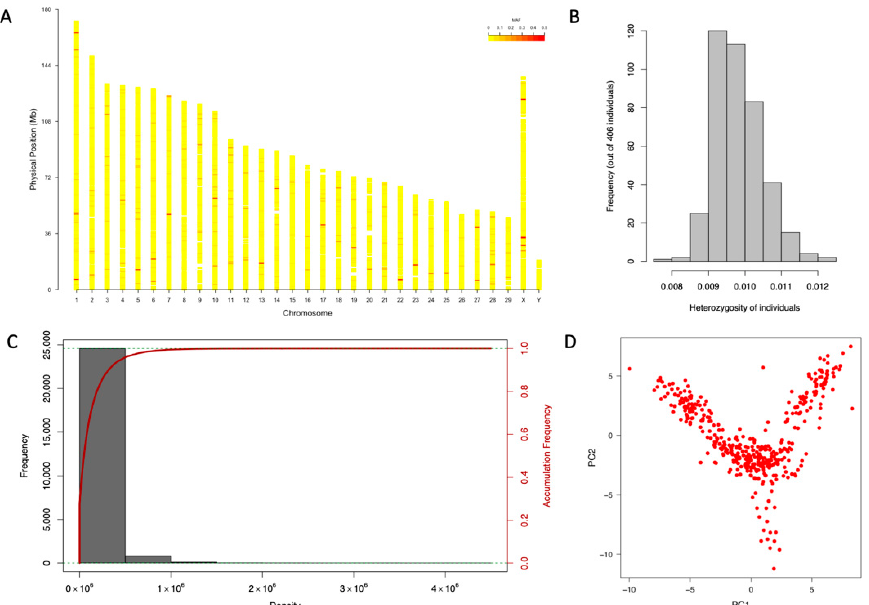
Figure 2. The distribution of genotype and population stratification. In total 25,537 SNPs are marked in the 29 autosomes and two (X and Y) sex chromosomes. The relative positions in the chromosomes were used to indicate marker density ( A ). The heterozygosity frequency of all 406 individuals is shown as bar plot ( B ). Marker density and accumulation frequency are plotted in the figure ( C ). All markers were used to interpret population structure with PCA ( D ).